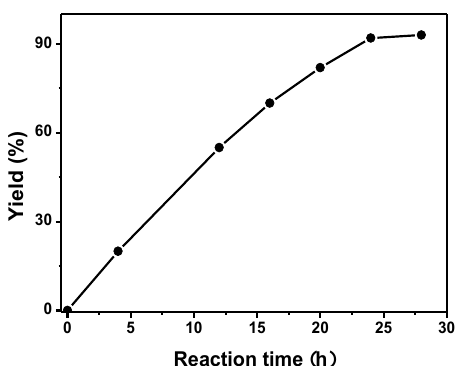
Figure 2. Effect of reaction time on the product yield over CuI and [P4444][Im]; Reaction conditions: 1a , 1.0 mmol, 2a , 1.0 mmol, CuI, 0. mmo, [P4444][Im], 0.1 mmol, CO 2 (1 atm), 30 °C. The yield was isolated yield. Table 2. Three-component reactions of propargylic alcohols(1), amines(2) and CO 2 under optimized conditions a .